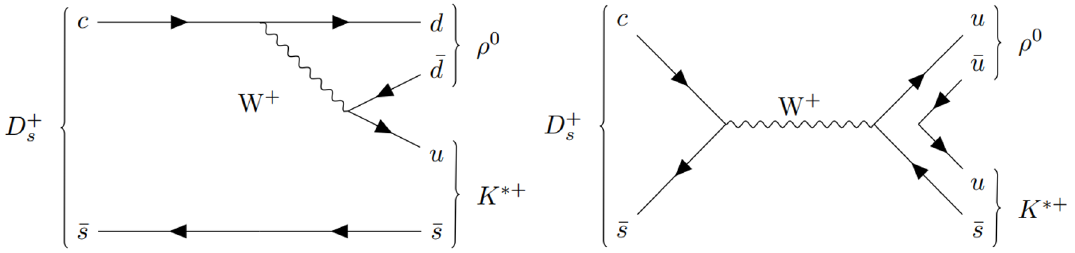
Figure 2 . The T -diagrams (left) and A -diagrams (right) for the decay D +